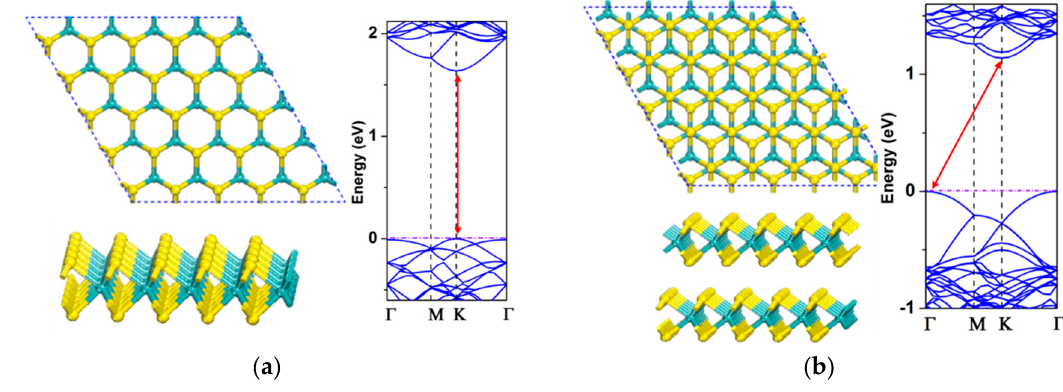
Figure 1. A 5 × 5 supercell geometric structure and electron structure of the MoS 2 monolayer ( a ) and bilayer ( b ) [32]. Copyright under CC BY license.